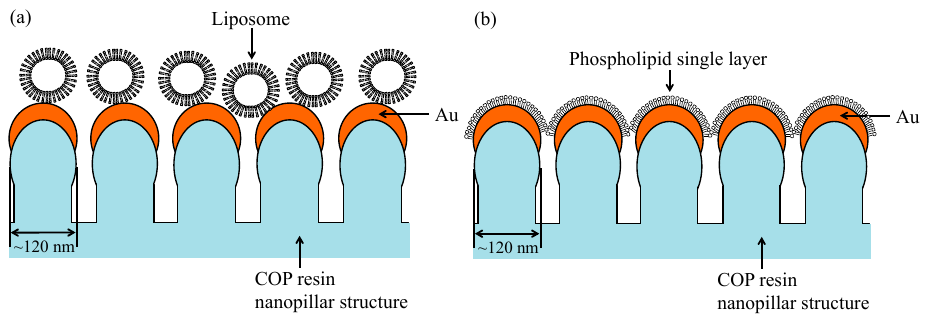
Figures 3. Cross-sectional illustrations of LSPR sensor immobilized with ( a ) liposomes and ( b ) phospholipid single layer.